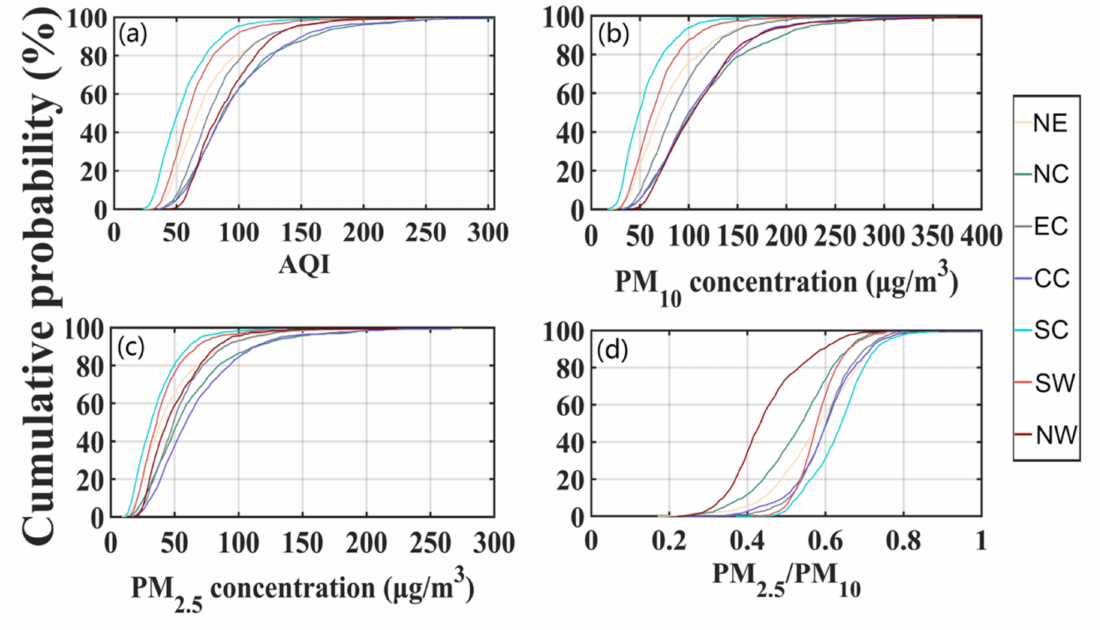
Figure 6. The cumulative distributions of daily regional averaged ( a ) AQI, ( b ) PM 10 concentration, ( c ) PM 2.5 concentration, and ( d ) PM 2.5 /PM 10 in seven geographic regions (classified in Table 1) during